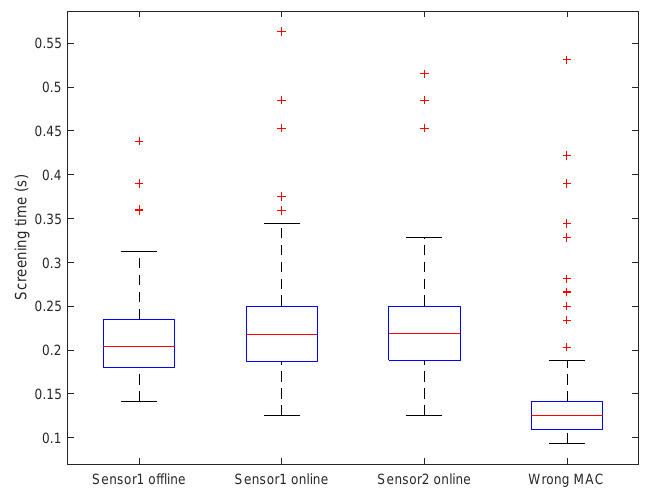
Figure 10. Single MAC screening time box plot